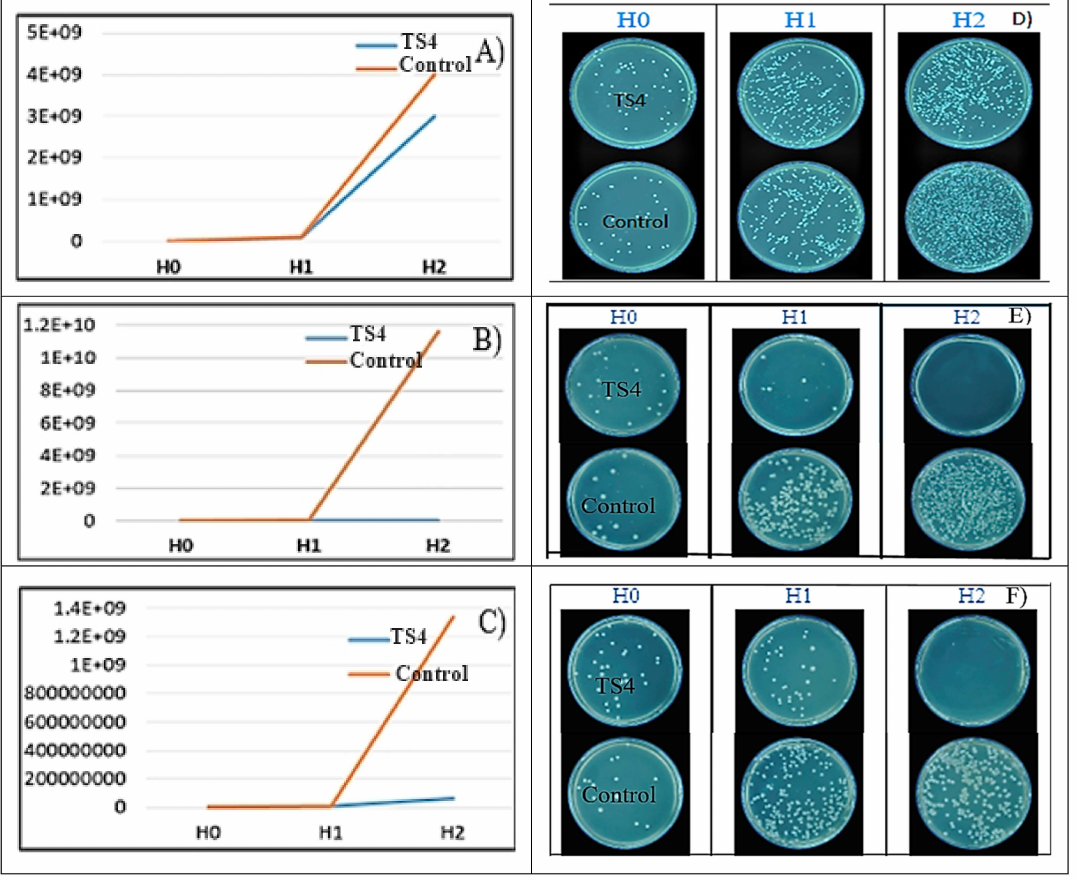
Figure 7. Graphical and visual representation of the growth rate for S. aureus ( A , D ), E. coli ( B , E ), P. aeruginosa ( C , F ) in the presence of TS4 (beech extract + AgC 2 H 3 O 2 pH = 9) and in the absence of TS4 (Control) at: initial time—H0, 3 h—H1, and 6